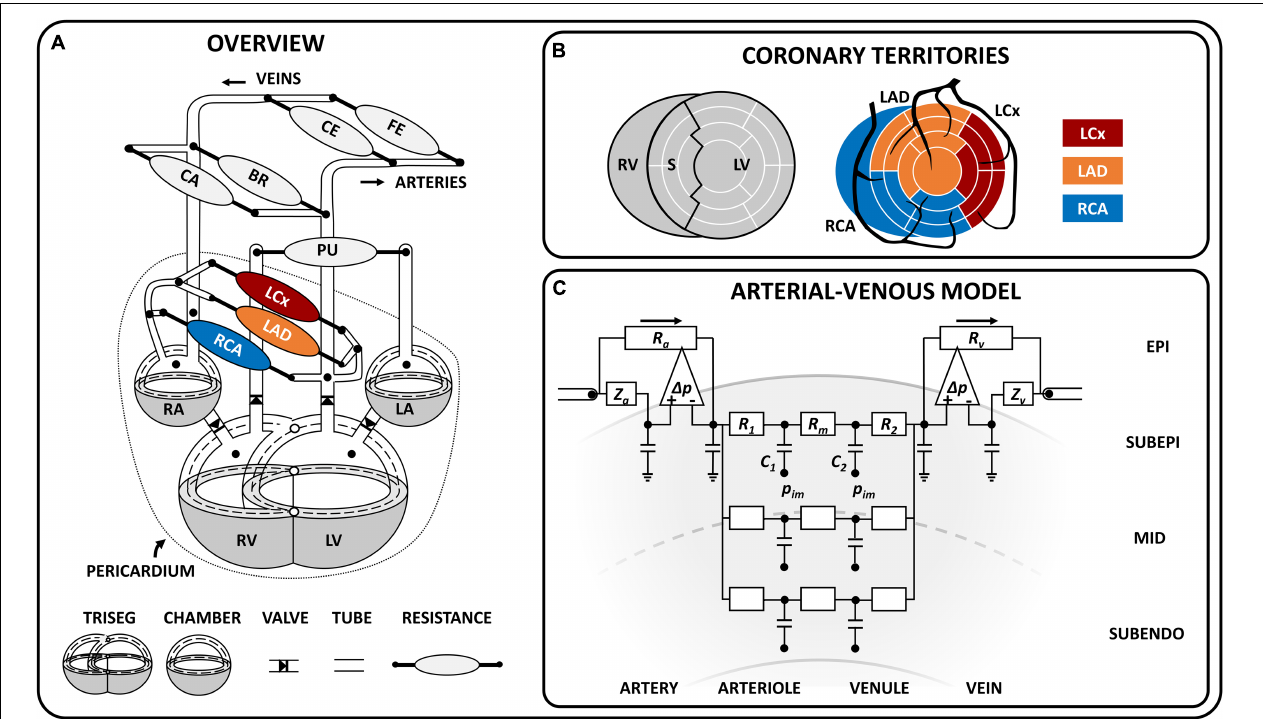
FIGURE 1 | Schematic model overview. (A) Schematic representation of the closed-loop cardiovascular CircAdapt model, including the TriSeg module (Lumens et al., 2009) [which allows mechanical interaction at the junction ( ◦ ) between the left (LV) and right (RV) ventricle and the septal (S) wall], the chamber module (Arts et al., 2005), valve module (Palau-Caballero et al., 2016), one-dimensional tube module (Heusinkveld et al., 2019), and zero-dimensional arterio-venous resistances for systemic and pulmonary circulation (Arts et al., 2005) as well as coronary circulation. The dashed line indicates the midwall volume; the dotted line indicates the pericardium, which surrounds the heart and coronary circulation. The coronary circulation included three major branches, namely the left circumflex (LCx), left anterior descending (LAD) and right coronary (RCA). (B) Schematic overview of the territory assignment of the three main coronary branches. The LV and S wall were divided into 12 and 5 segments, respectively, using the MultiPatch module (Walmsley et al., 2015). Coronary territories of the LCx, LAD and RCA were assigned to individual segments according to the AHA proposed 17-segment model (Cerqueira et al., 2002). (C) Coronary arterial-venous model with epicardial arterial inlet and venous outlet accounting for wave behavior in the connecting 1D vessel. The pressure difference-controlled flow source ( (cid:49) ) accommodates high flow conditions (i.e., low peripheral resistance) and makes solving the differential equation for this highly non-linear system less complicated. The arterial-venous model is subdivided into three transmural layers (subepicardium, mid, subendocardium), each containing an arteriolar and venular compartment (with compliances C 1 and C 2 , resistances R 1 and R 2 , and a shared resistance R m ) . The intramyocardial pressure ( p im ) varies between layers and acts on the compliance. BR, brachial; CA, cerebral; CE, celiac; FE, femoral; LA, left atrium; RA, right atrium. Symbols: R a , arterial resistance; R v , venous resistance, Z a , arterial wave impedance, Z v , venous wave